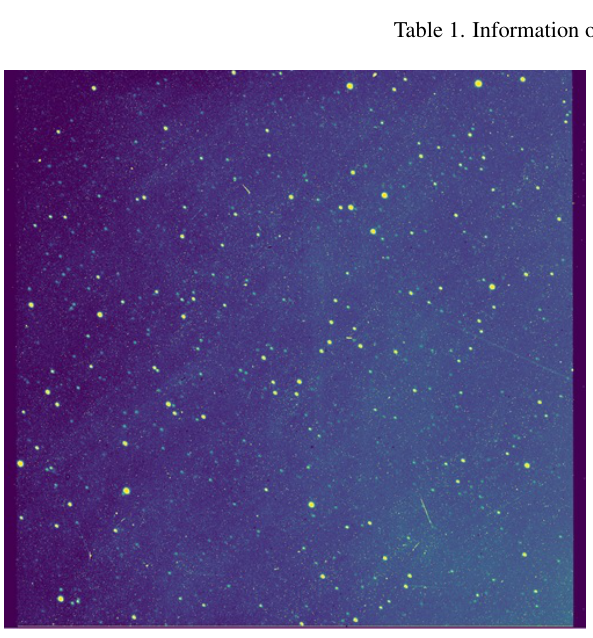
Figure 9. No false positives when there are no moving targets in the images taken on day 333 rd of 2018, track 1